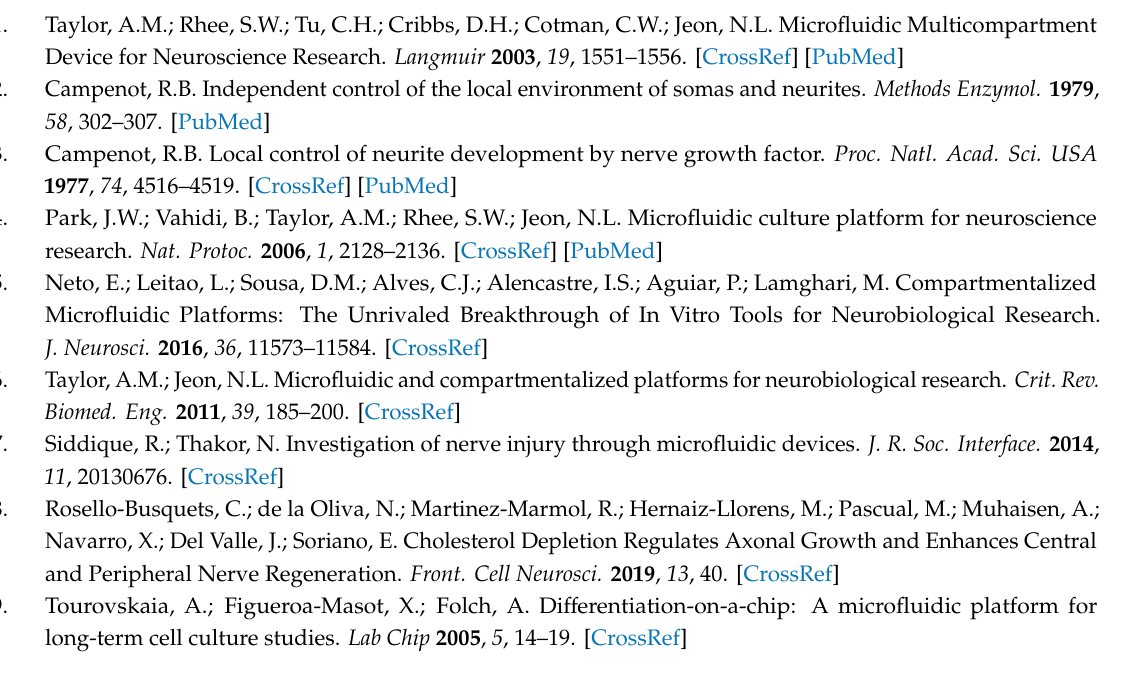
Figure S1: Optogenetic platform illumination; Figure S2: Calcium waves in spinal cord slides after optogenetic stimulation. Figure S3: Quantification of the displacement ( µ m) of ChR2-C2C12 myotubes under pulsated light stimulation. Figure S4: Axon regrowth in axotomized devices analyzed by Calcein TM labeling. Video S1: Z stack animation of aligned myotubes inside the chamber in the MFD. Video S2: Example of the electrical stimulation on C2C12-ChR2 cultured myotubes. Video S3: Example of continuous optical stimulation on C2C12-ChR2 myotube contractibility. Video S4: Example of pulsatile optical stimulation on C2C12-ChR2 myotube contractibility. Video S5: Z stack animation of double labelled eYFP axons and BTX-Alexa Fluor 595. Video S6: Contraction of C2C12-ChR2-negative myotubes induced by optical stimulation of spinal cord explants. Video S7: Example of vacuum-assisted axotomy in eYFP fluorescence axons. Video S8: Impairment of myotube contraction after axotomy under continuous illumination of ChR2-positive spinal cord